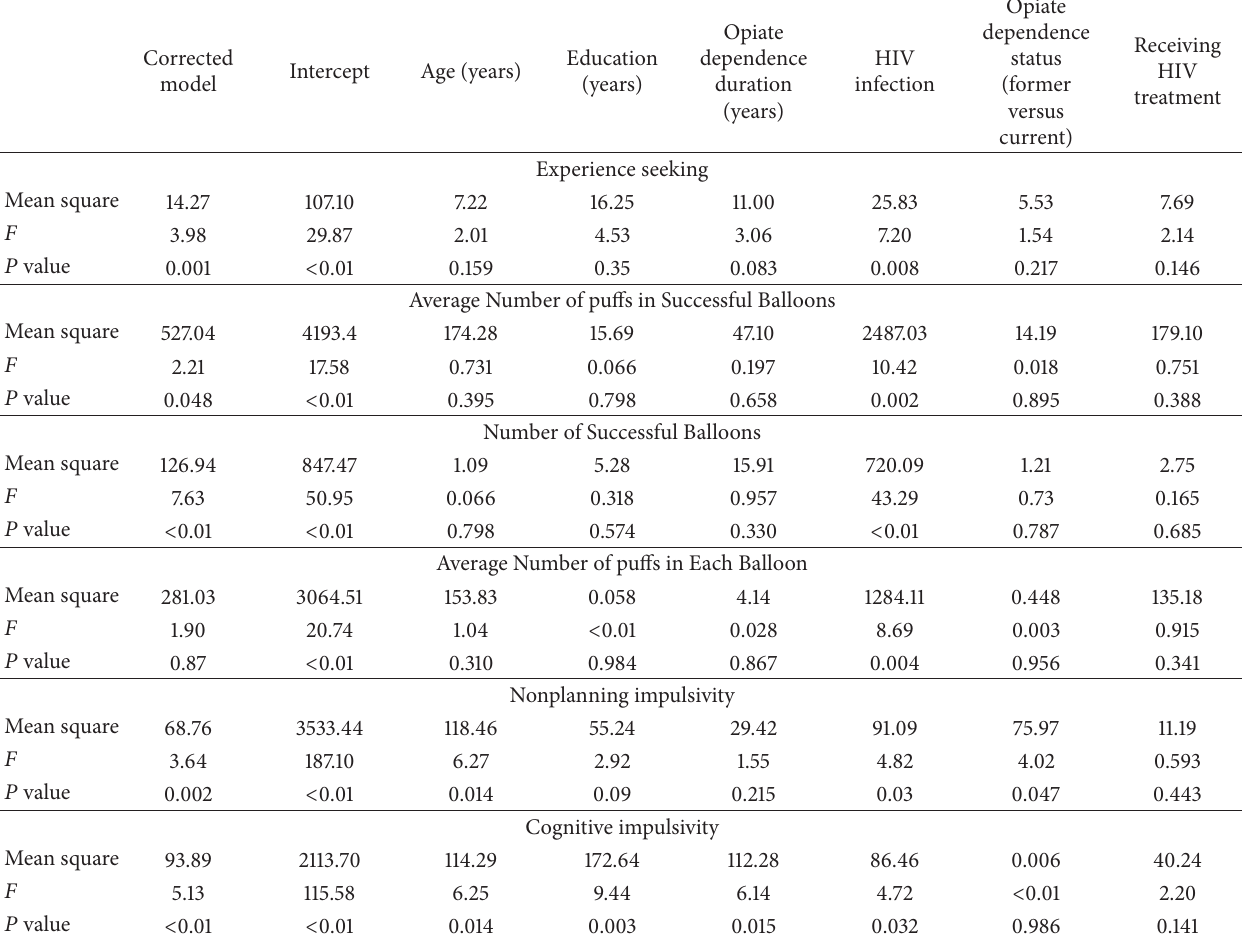
Table 4: Models of the covariance analysis (ANCOVA) for exclusion of the influence of covariates were obtained for experience seeking domain of the sensation seeking scale, variables of the balloon analogue risk task (Average Number of puffs in Successful Balloons, Number of Successful Balloons, and Average Number of puffs in Each Balloon), and the nonplanning and cognitive impulsivity from Barratt Impulsiveness